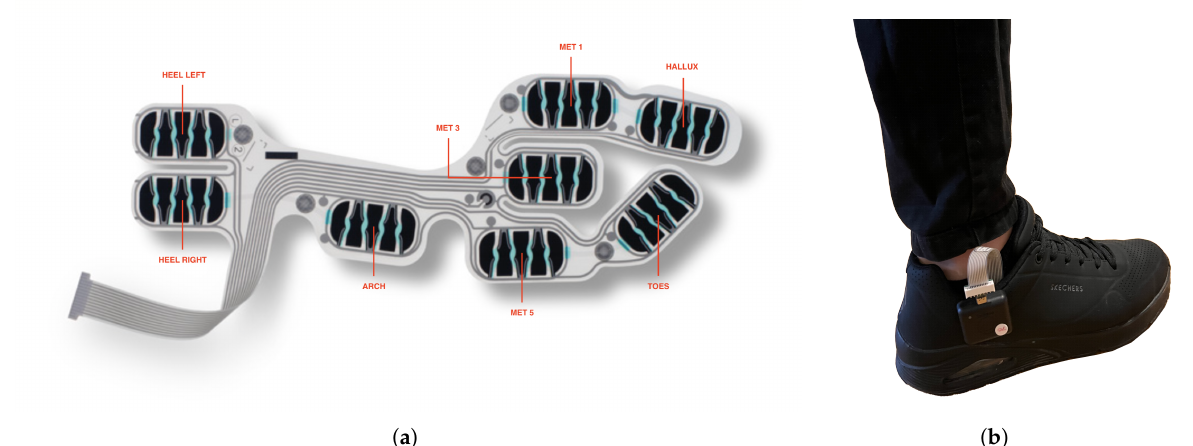
Figure 1. ActiSense Kit, IEE Luxembourg S.A. ( a ) IEE Smart Foot Sensor ( b ) Example of how the system is worn by the